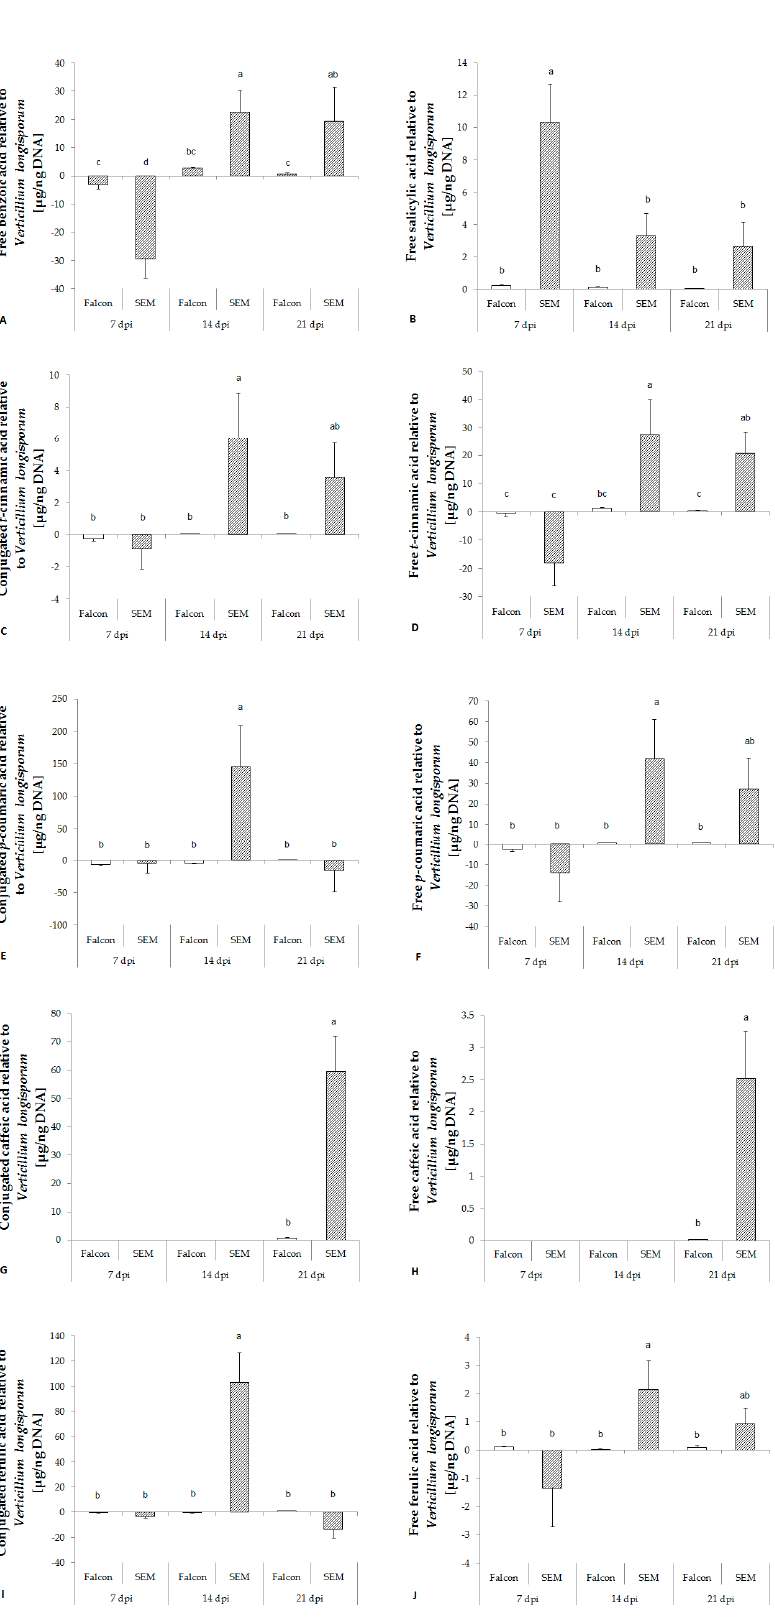
Figure 3. Response of free benzoic acid ( A ), salicylic acid ( B ) and di ff erent phenolic acids ( C–L ) in the hypocotyl of B. napus cv. Falcon and SEM upon infection of V. longisporum . Bars indicate standard errors. Di ff erent letters indicate significant di ff erences among the treatments (LSD test, p < 0.05). FW, fresh weight; n.s., no significant di ff